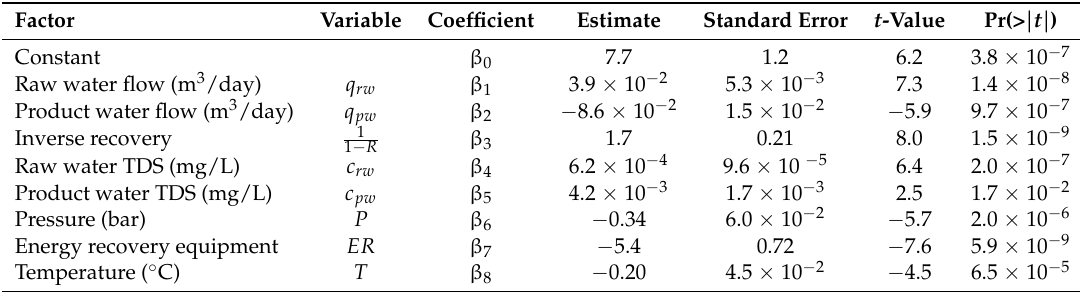
Table 3. Multiple linear regression results for the small-scale model of desalination operations ( n = 45) revealed a reasonable model fit with highly significant coefficients. Values have been rounded to two significant figures.